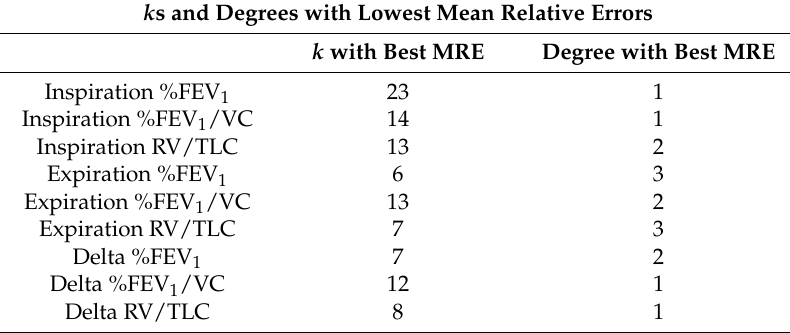
Table 1. k s and degrees with the lowest mean relative error.